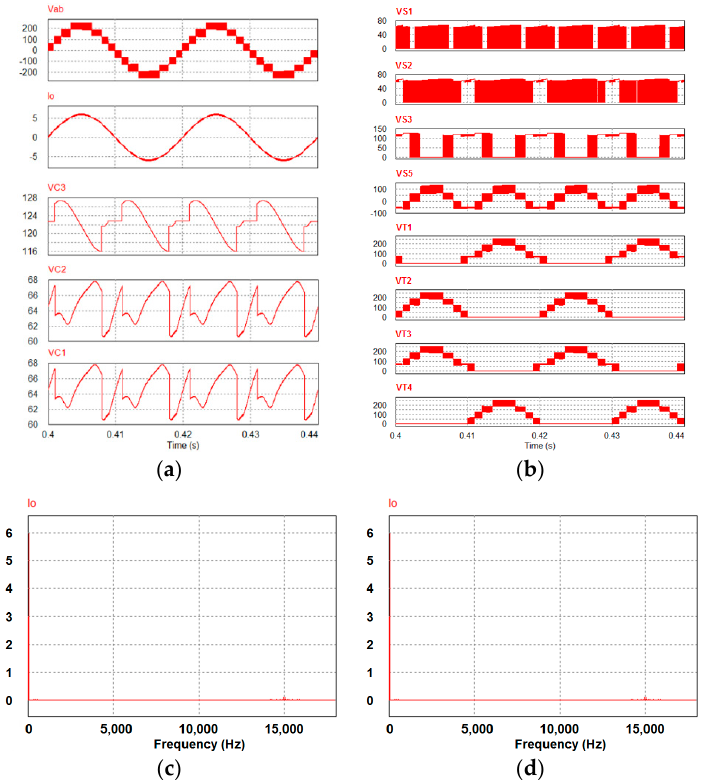
Figure 7. Simulation results of the proposed NLBI when d S 1 = 0.4. The waveforms from top to bottom: ( a ) nine-level output voltage V ab , load current i o , capacitors C 3 – C 1 voltage; ( b ) switches S 1 , S 2 , S 3 , S 5 voltage and switches T 1 – T 4 voltage of H-bridge circuit, ( c ) harmonic spectrum of nine-level output voltage and ( d ) harmonic spectrum of load